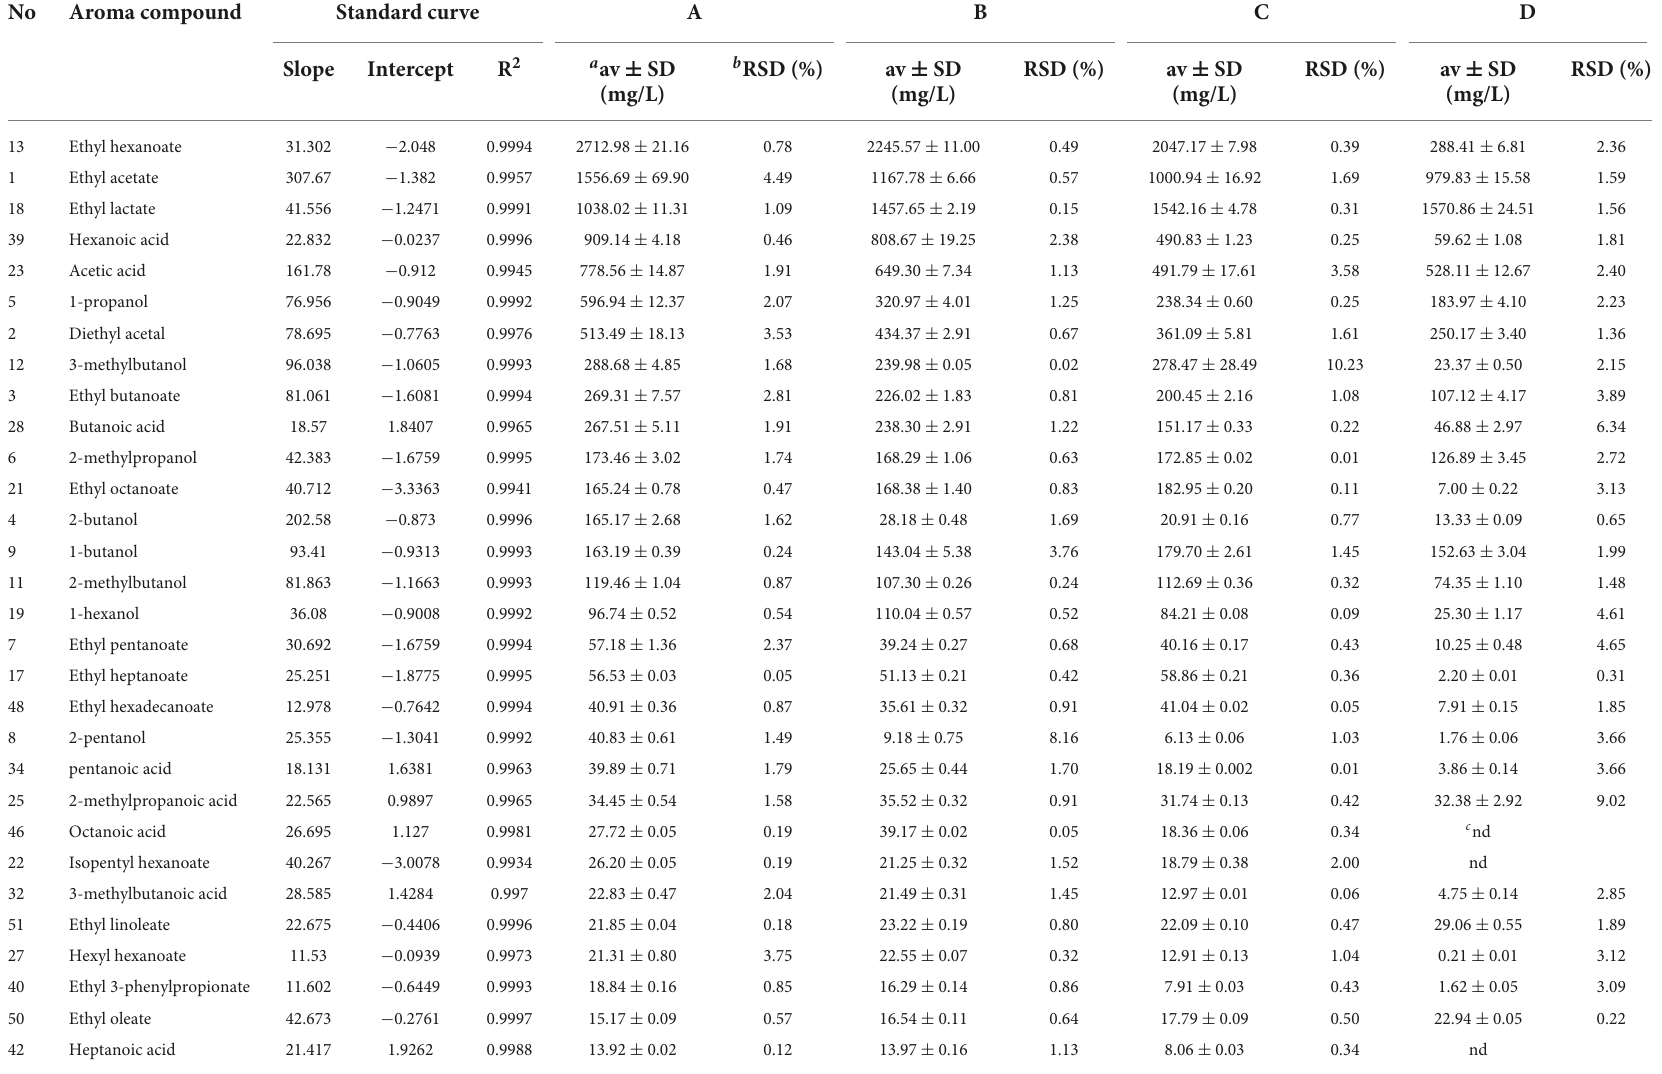
TABLE 2 Standard curves and concentrations of 52 aroma compounds in four grades of base